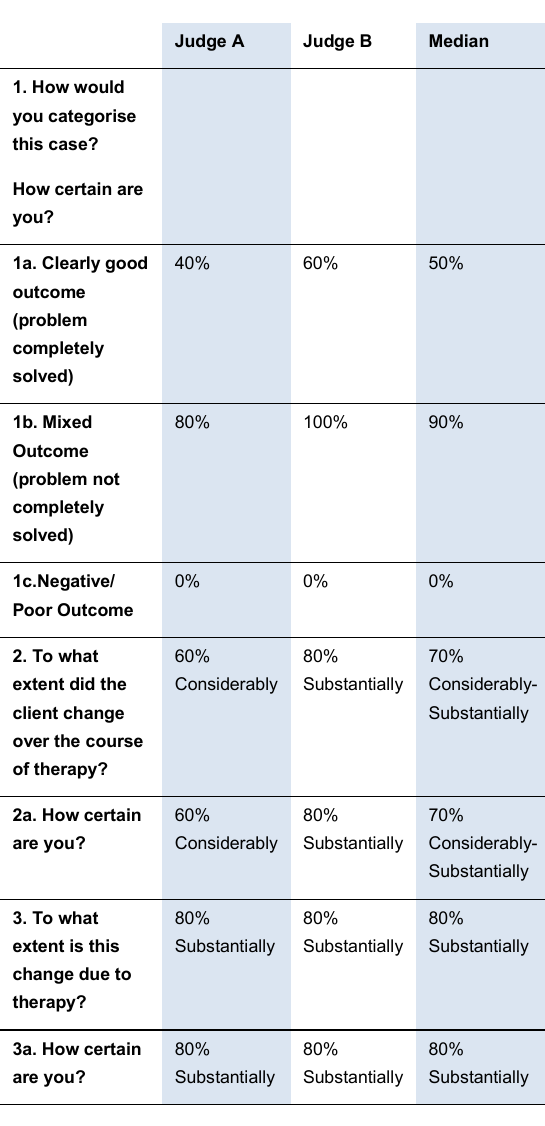
Table 3. Adjudication